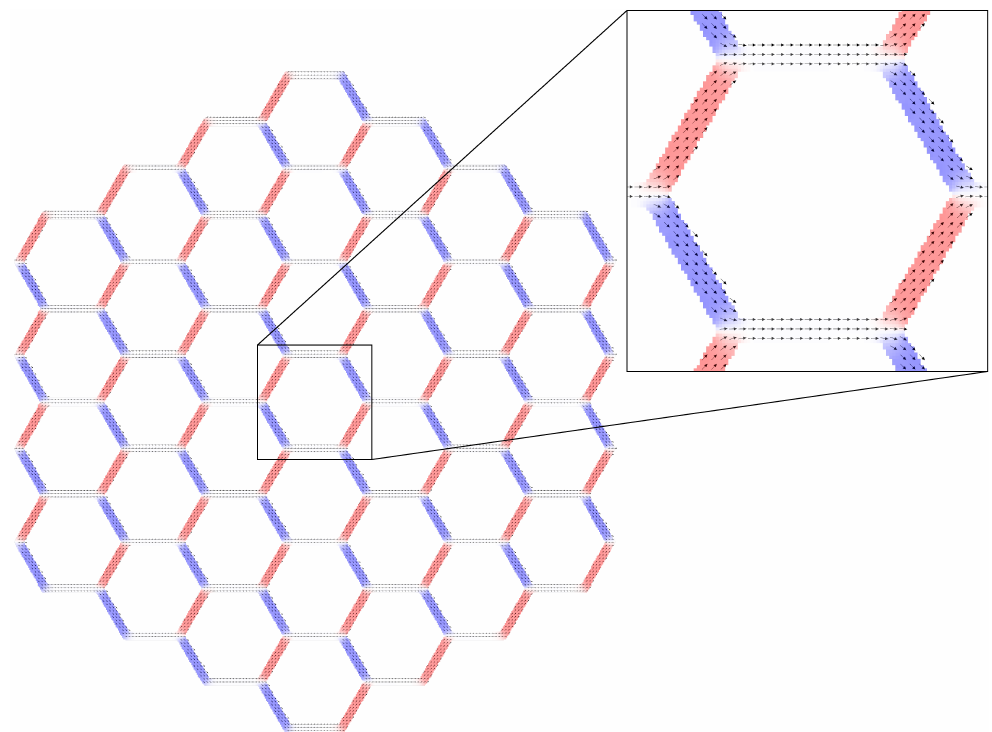
Figure 3. Ground magnetic state calculated for the case r = 1. Local magnetization direction is represented by arrows (subsampled with respect to the actual, very large number of cells) and background color, which depends on vector orientation with respect to the horizontal direction. An expanded view of the central hexagon is shown in the